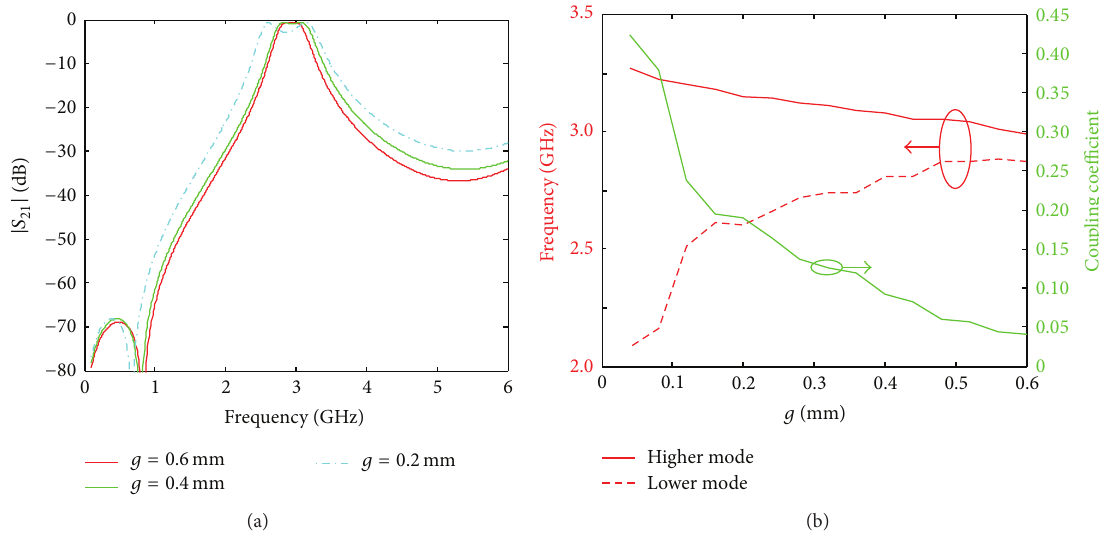
Figure 2: (a) Simulated transmissions for the twist SRR inspired filter unit at different gaps and (b) the changing properties for the two resonance frequencies and the calculated mix coupling coefficient as functions of gap 𝑔 .